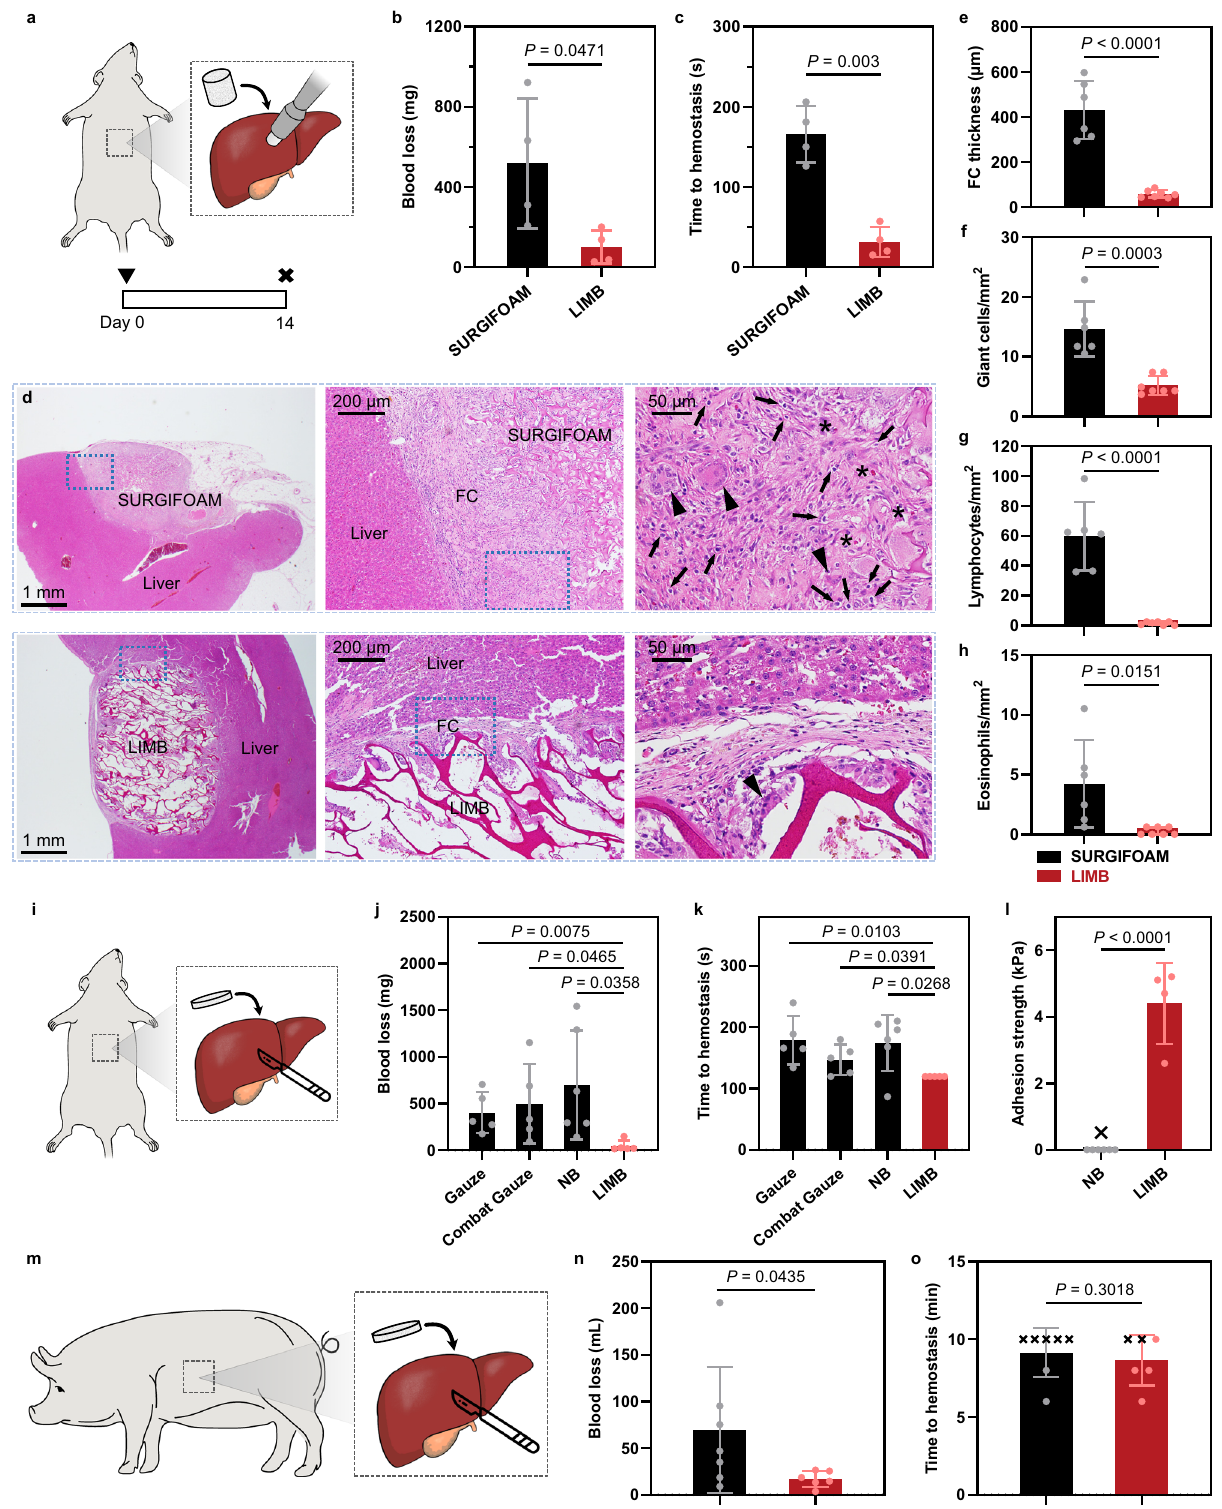
Fig. 5 | In vivo validation of the safety and ef fi cacy for hemorrhage control. a Illustration of a liver volumetric defect non-compressible hemorrhage model on rat without applying pressure. b Blood loss and c time to hemostasis comparison. d Histologyimagesshowingtheimplantsafter2-weeks. “ Triangle ” symbolspointto foreign-body type giant cells; “ Arrow ” symbols point to lymphocytes; “ Star ” sym- bols point to eosinophils. e – h Immune responses comparisons. i Illustration of deep incision hemorrhage on rat liver. j , Blood loss and k , time to hemostasis comparisons among different hemostats. l Adhesion strength comparison after